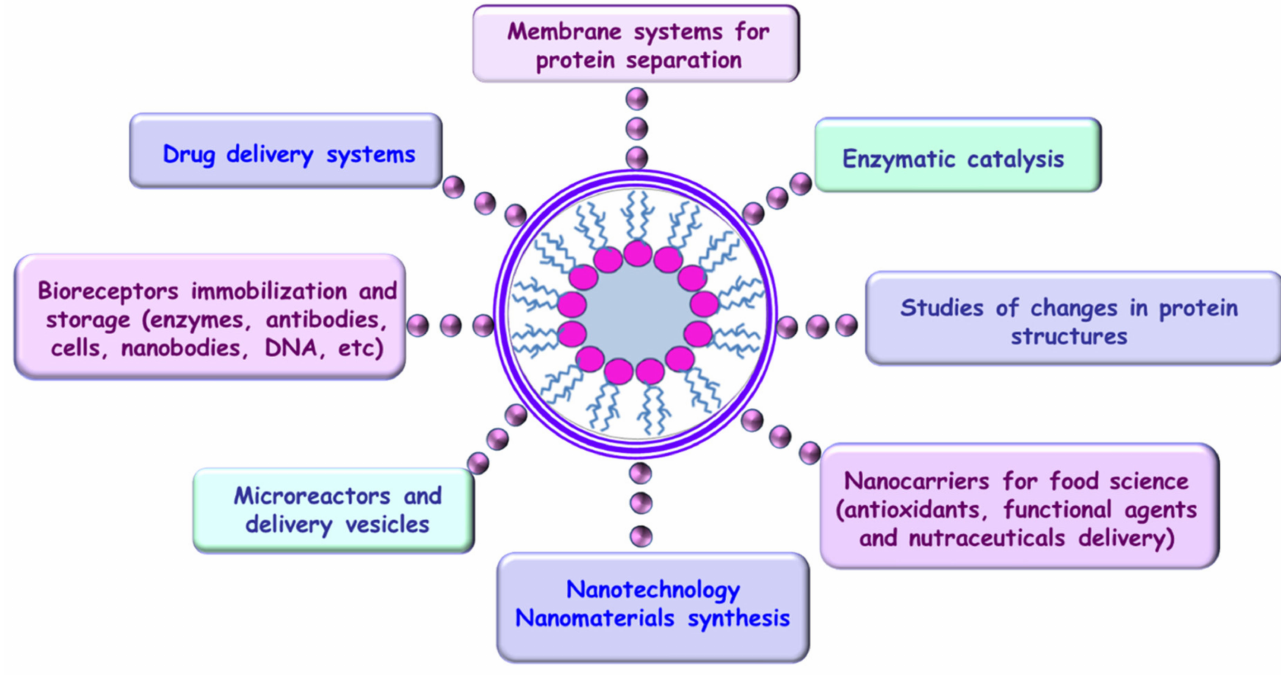
Figure 9. Self-assembly and application fields of reverse